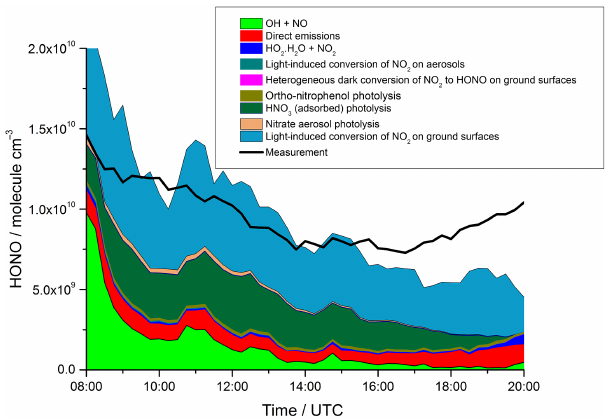
Figure 9. Average daytime diurnal profile of the modelled HONO from different sources shown as a compound area plot, as described in Sect. 3.3 of the text, showing the result of increasing the reac- tive uptake coefficient of the light enhanced conversion of NO 2 on ground surfaces (see text for details). Also plotted (black trace) is the measured